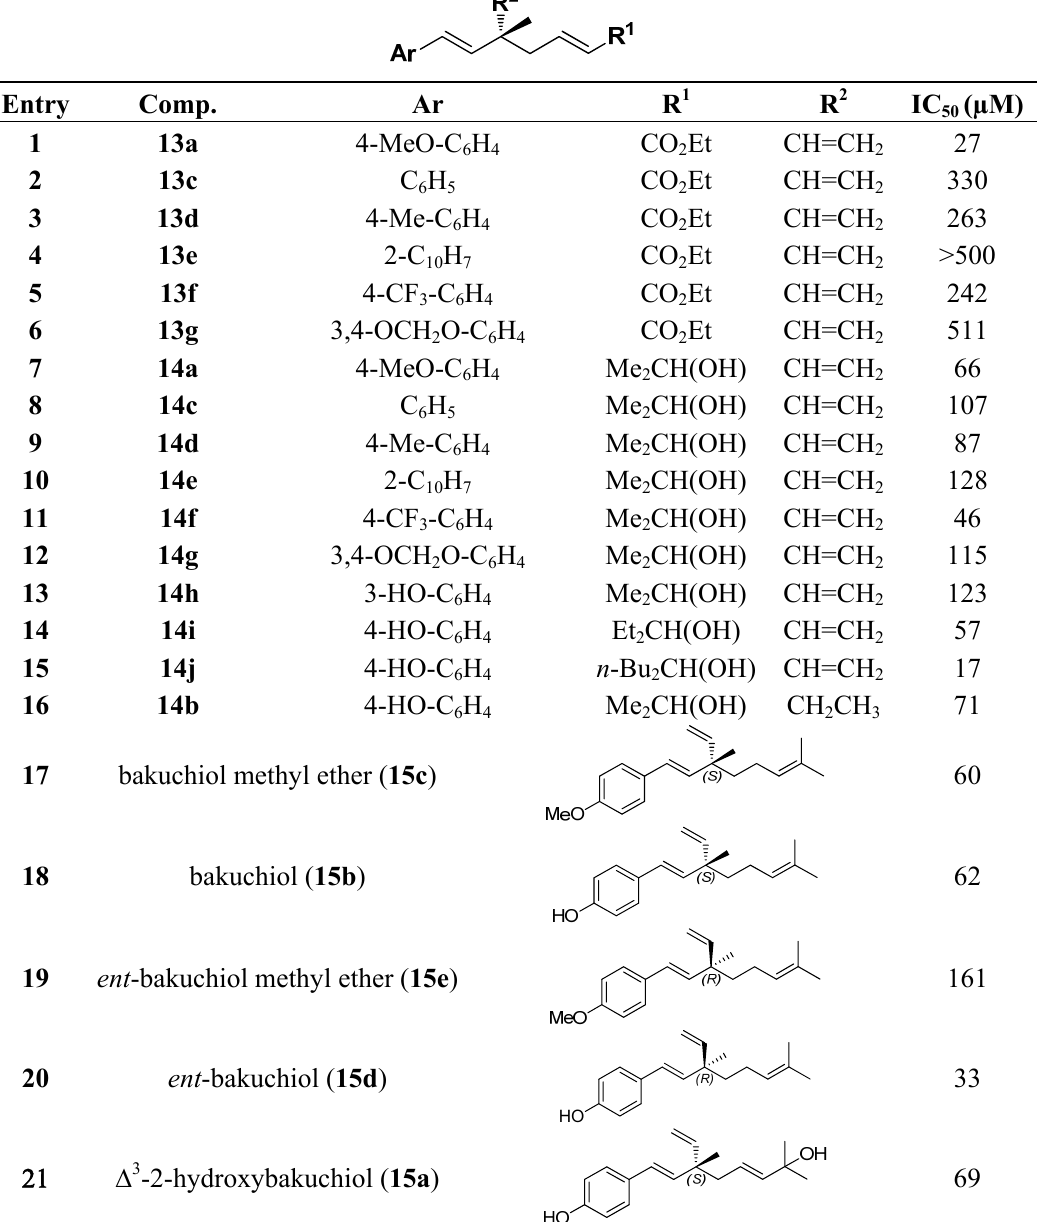
Table 1. Cytotoxic activities of ∆ 3 -2-hydroxybakuchiol and its analogues against rat UMR106 osteosarcoma